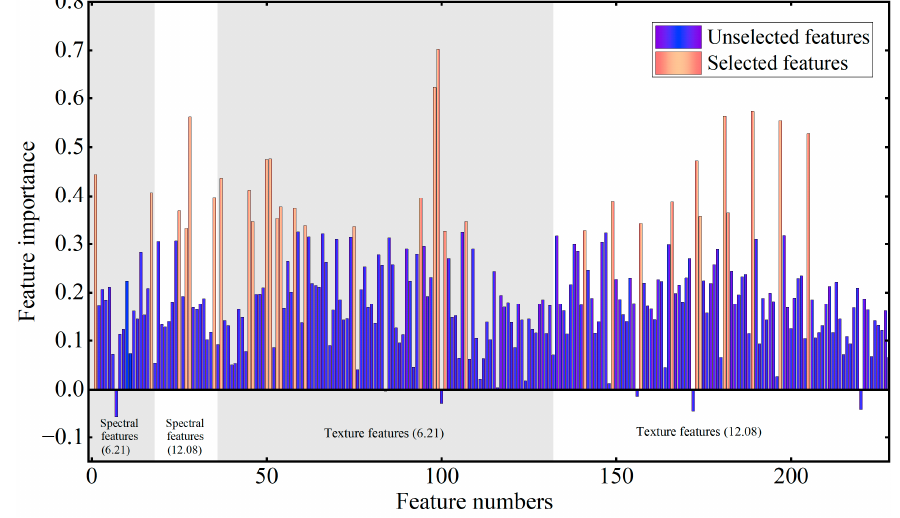
Figure 13. Importance ranking of S2 features.